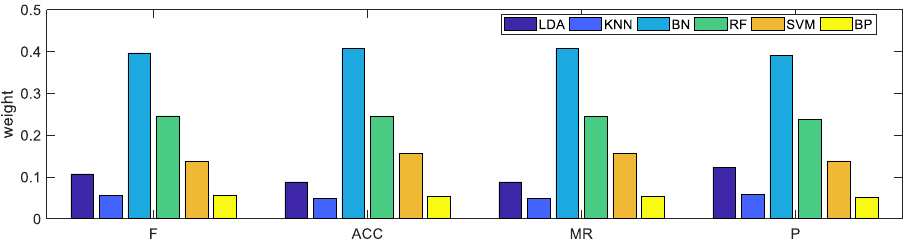
Figure 3. Weight of each base classifier relative to each performance evaluation indicator.